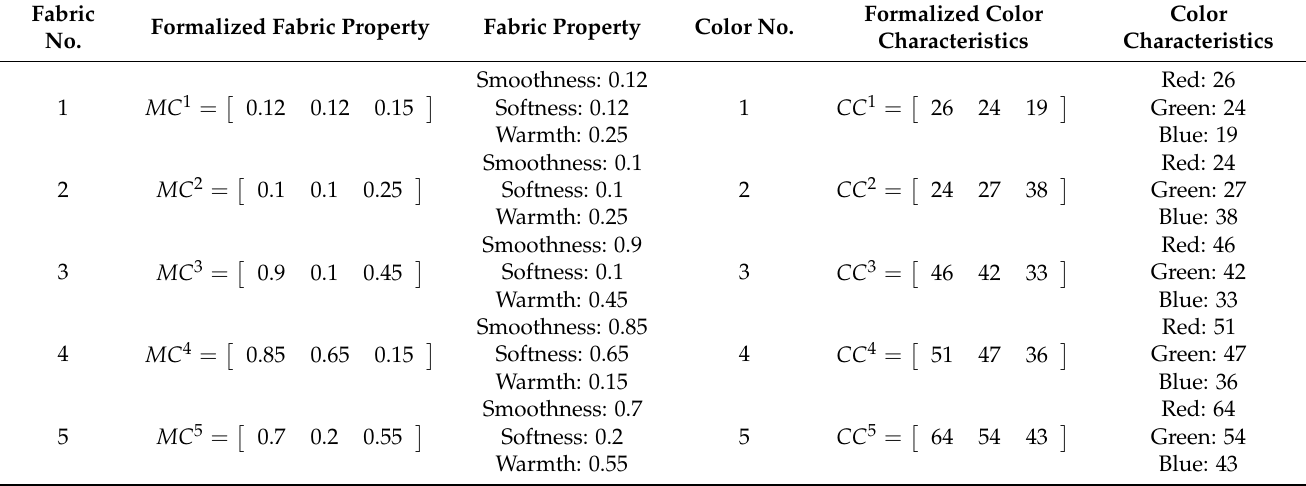
Table 5. The characteristics of the color and